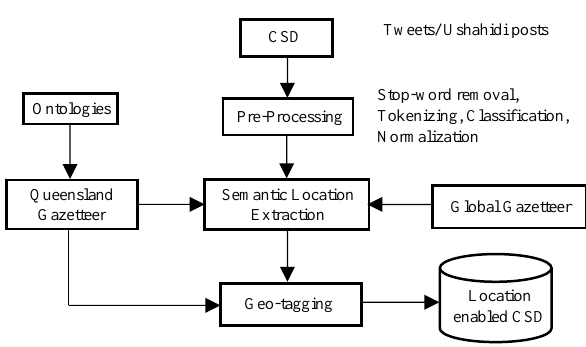
Figure 2. Semantic CSD Location extraction and Geo-tagging